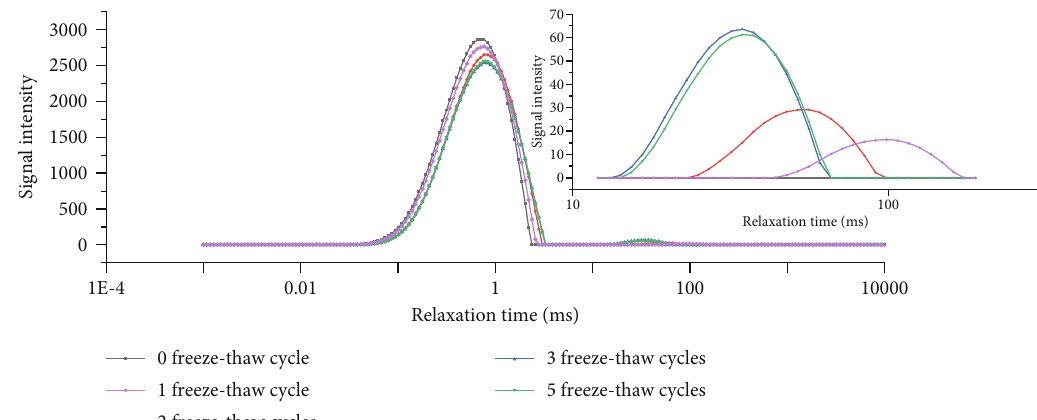
Figure 6: Variation of T2 spectrum with di ff erent freeze-thaw cycles.